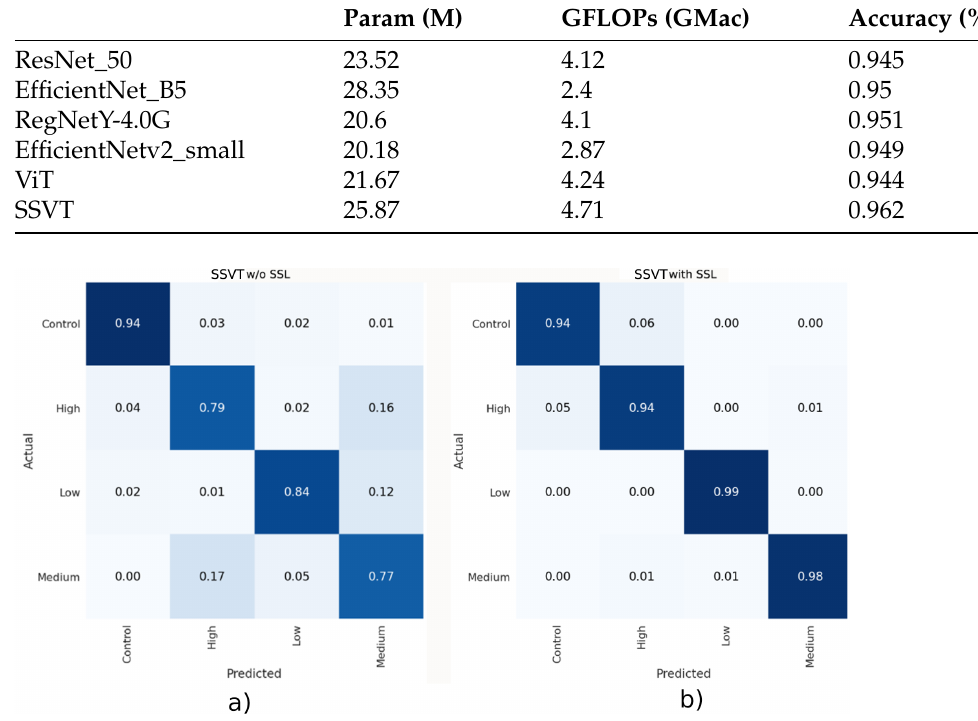
Table 5. The performance comparison of the proposed SSVT with the existing conventional models.